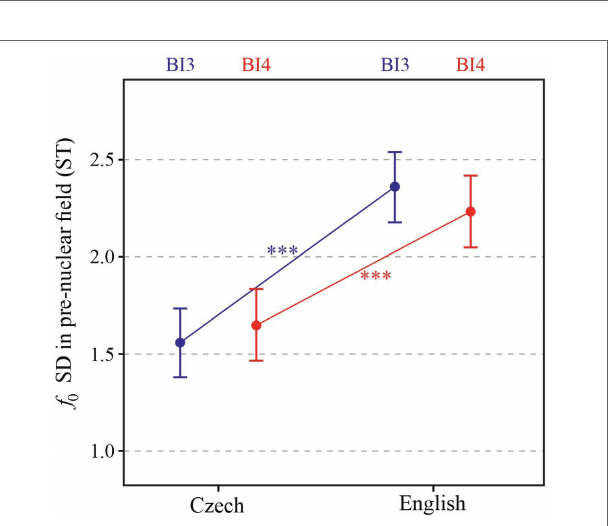
FIGURE 7 | Standard deviation of f 0 in the nuclear portion of each prosodic phrase, depending on L anguage and P rosodic break type (BI3 in blue, BI4 in red, and BI4-d in black). ** p < 0.05; *** p < 0.001.